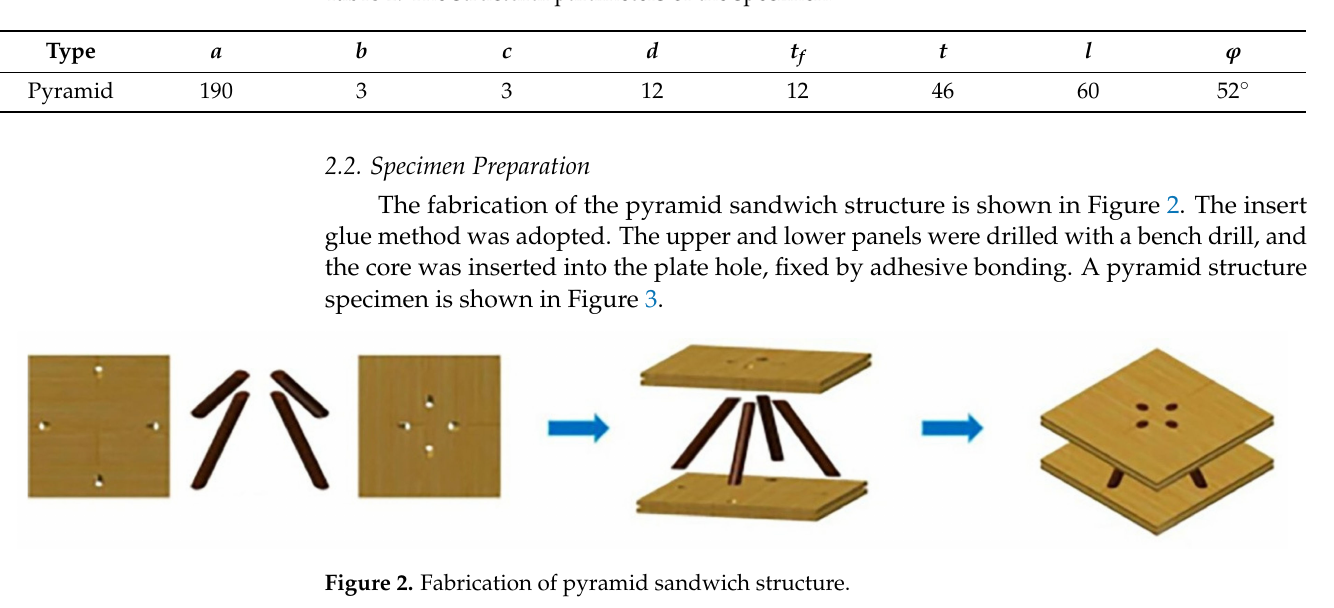
Table 1. The structural parameters of the specimen.